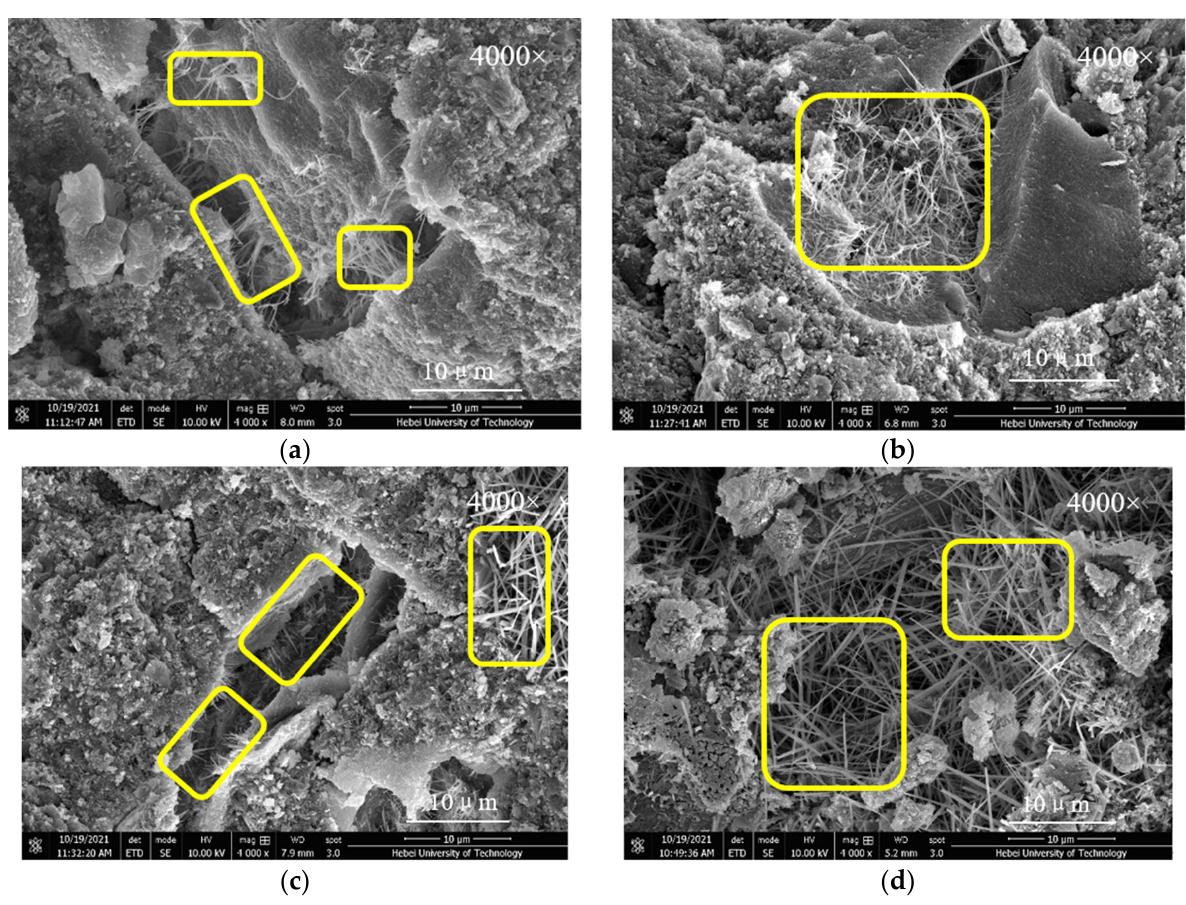
Figure 9. SEM images of MOSC with different mineral admixtures after 3 days of curing: ( a ) C; ( b ) C-10FA; ( c ) C-10MK; ( d ) C-(5MK+5FA). Remark: Phase 517 is shown in the yellow frame.